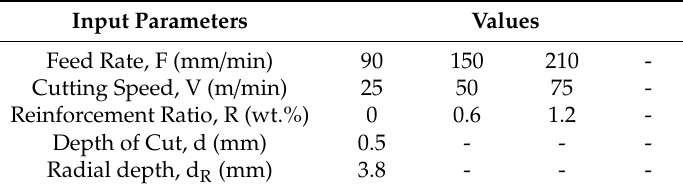
Figure 2. Architecture of ANFIS model [54]. Table 3. Machining parameters and their selected